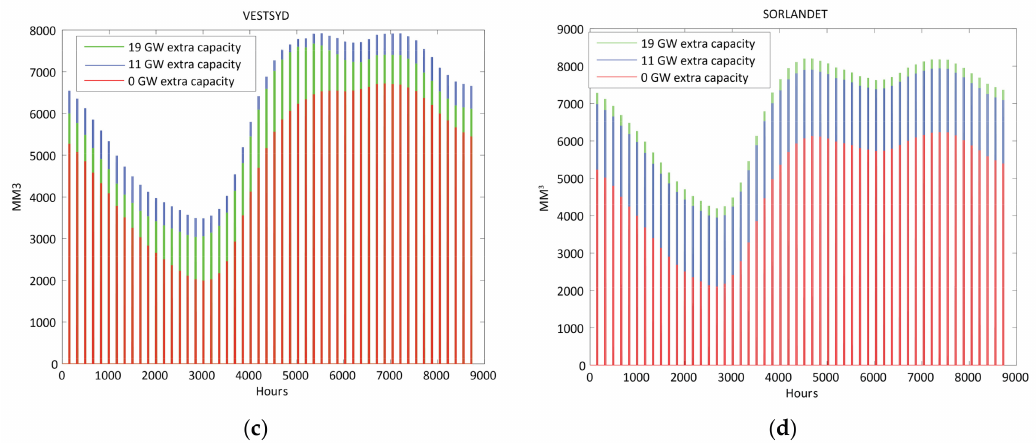
Figure 4. Yearly pattern reservoir level averaged over 75 years for the four regions with increased hydropower generation capacity: ( a ) VESTMIDT; ( b ) TELEMARK; ( c ) VESTSYD; ( d )